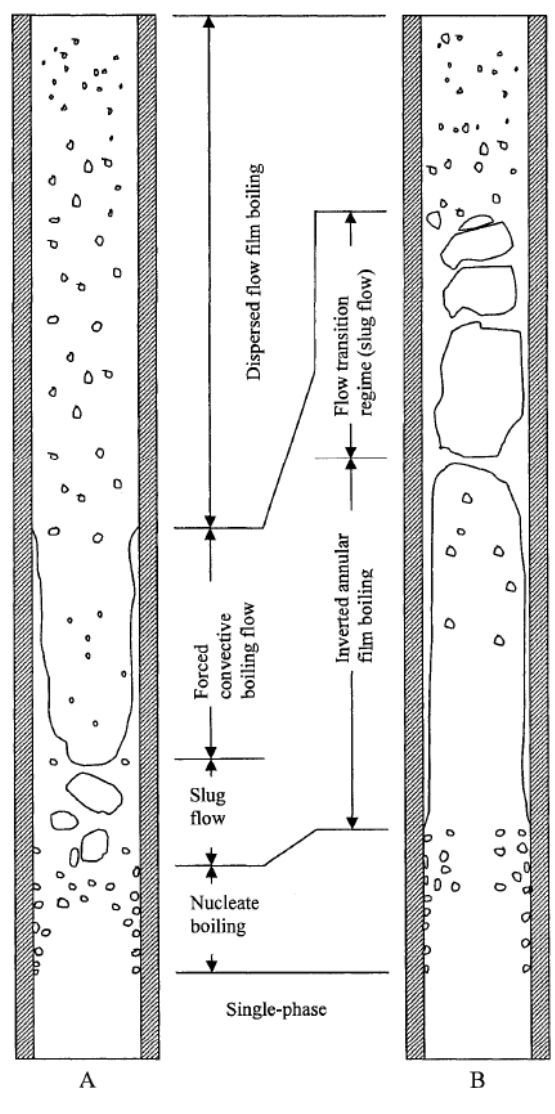
Figure 1. The difference between IAFB (right) and DFFB (left) regime inducted by different heat flux [4].